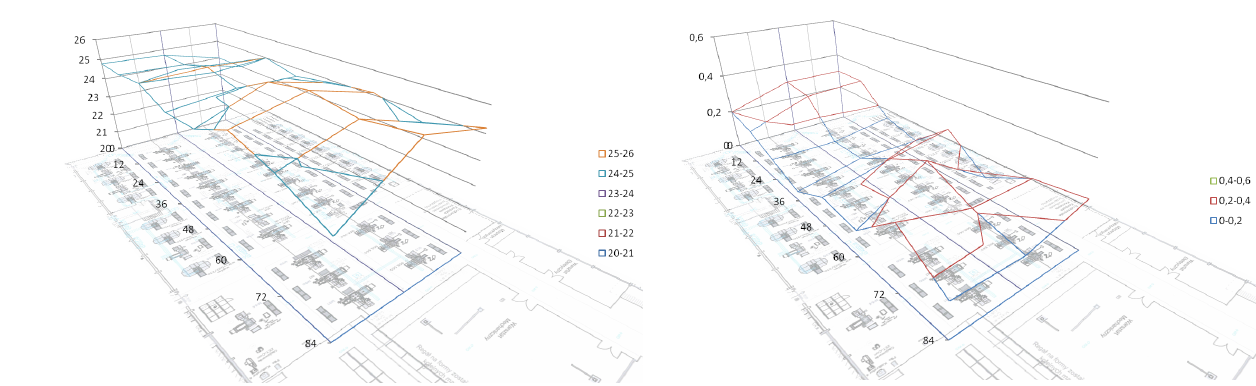
Figure 1: Air velocity in Hall1 at a height of 2 m, m/s.